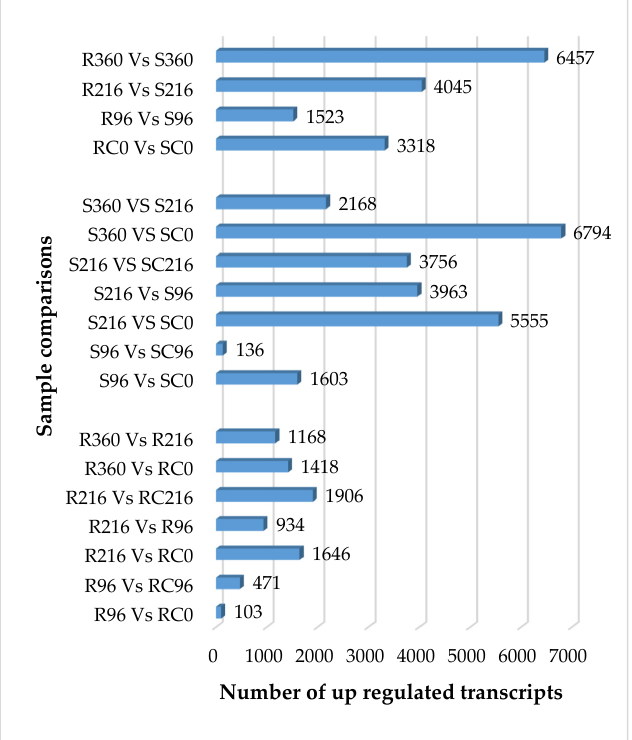
Figure 1. Number of DEGs (up regulated) in resistant and susceptible sorghum genotypes at different times after SCA infestation. Samples were taken 0 h, 96 h, 216 h, and 360 h after infestation of the plants with fourth instar apterous Melanaphis sacchari . R = resistant, RC = resistant control, S = susceptible, SC = susceptible